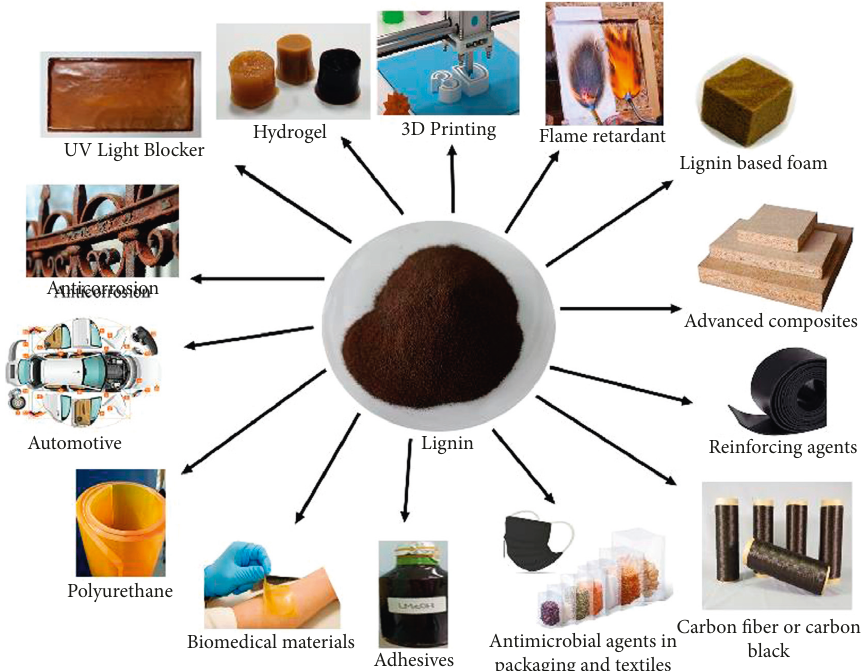
Figure 14: Potential application of lignin-based